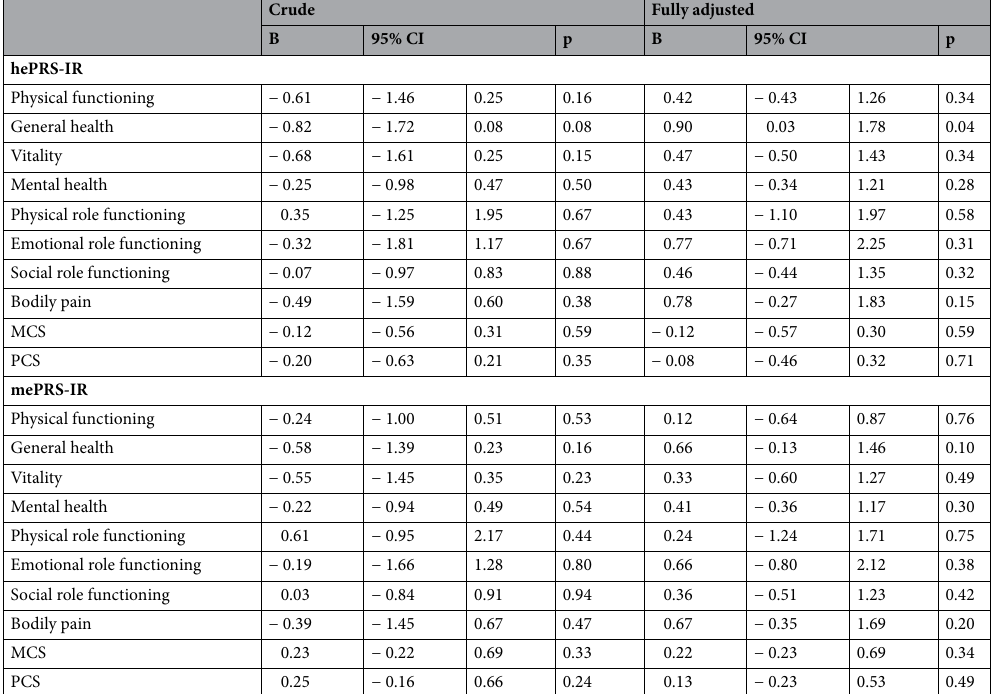
Table 3. The association between the biologically informed polygenic risk score for insulin receptor (ePRS-IR) and the physical component (PCS) and the mental component (MCS) of health-related quality of life (HRQoL) as well as the domains of the SF-36. Model 1 adjusted for age, sex and population stratification. Model 2 adjusted for Model 1 + smoking, alcohol usage, socioeconomic status, comorbidities, body mass index, leisure-time physical activity and comorbidities. PF physical functioning, GH general health, VT vitality, MH mental health, RP physical role functioning, RE emotional role functioning, SF social role functioning, BP bodily pain. hePRS-IR hippocampal biologically informed polygenic risk score for insulin receptor, mePRS-IR mesocorticolimbic biologically informed polygenic risk score for insulin receptor, B regression coefficient. P values were based on the bootstrap style method of 10,000